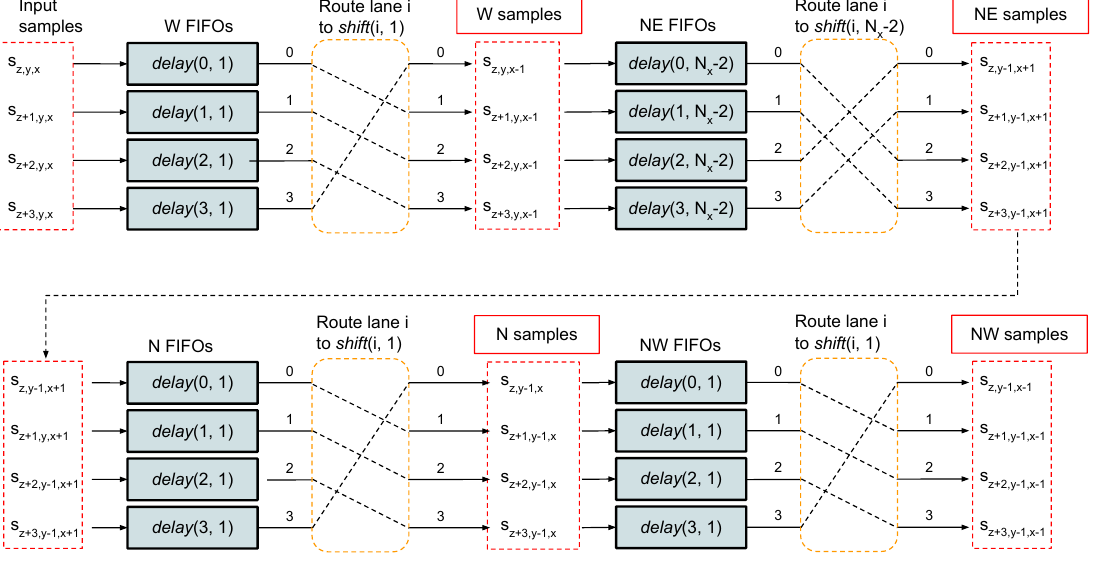
Figure 4. Sample delay processing chain described by delay ( i , ∆ t ) and shift ( i , ∆ t ) functions. For each lane i , there is a set of FIFOs with the depth determined by the delay ( i , ∆ t ) function. The outputs of FIFOs are then shifted according to the shift ( i , ∆ t ) function, so that the delayed samples are used as neighbors in ( W , NW , N , NE ) positions with respect to the samples